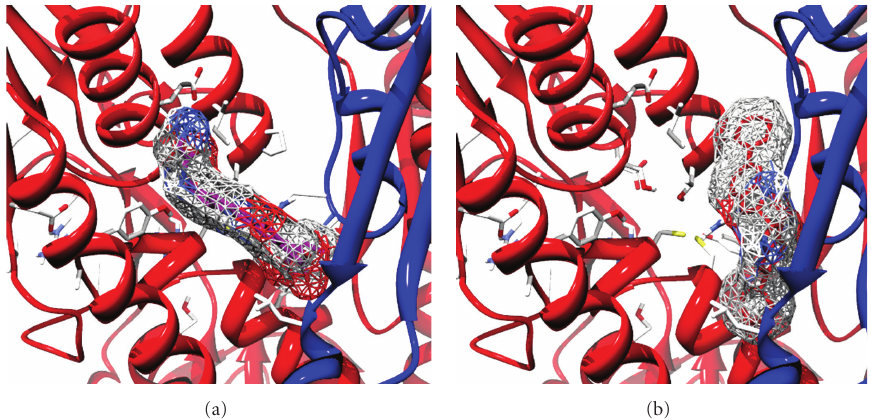
Figure 3: Compound 16 (a) of cluster 1 traversed between hydrophobic patches formed by Trp21, Met114 and Leu399, Pro492, and Pro398 where later is located in vicinity to the substrate-binding site, it also showed hydrogen bonding potential with Tyr110 of the active site, Tyr110 anchors the substrate to the active site by hydrogen bonding with the spermidine moiety. Compound 48 (b) of Cluster 2 binds to the Z site with hydrogen bonding potentials with His461, active site histidine base, and also with the residues which aid in orientation of substrate towards the active site.